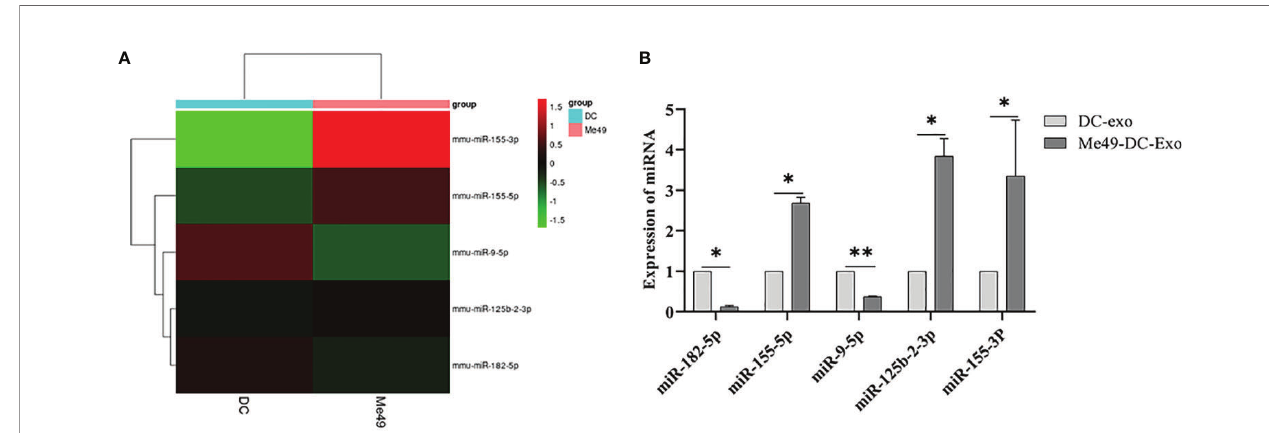
FIGURE 5 | High-throughput sequencing of total RNA extracted from DC-Exo and Me49-DC-Exo. (A) Heatmap of miRNA differentially expressed in DC-Exo and Me49-DC- Exo. (B) The expression levels of differential miRNA veri fi ed by qRT-PCR. * p < 0.05, ** p <